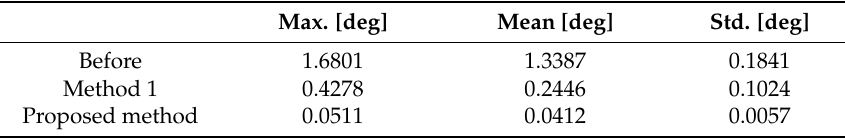
Figure 8. The angular deviation after calibration of the methods. Table 4. The statistics of the angular deviation after calibration of the methods.